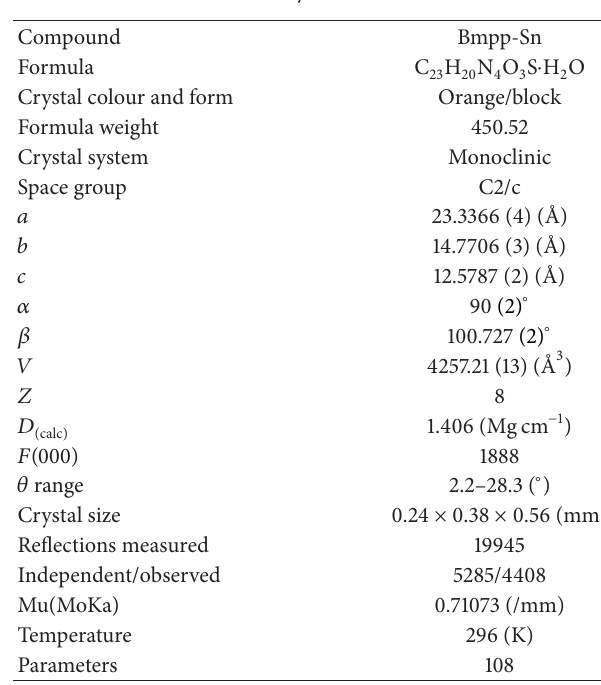
Table 1: Crystal data for 2